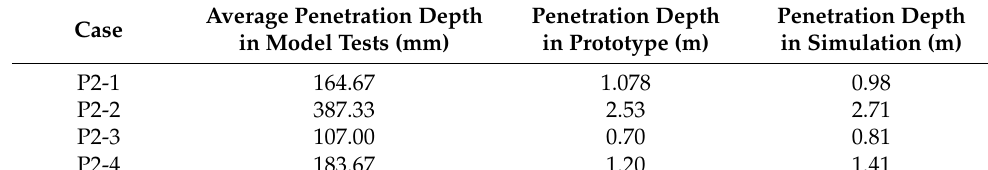
Table 15. Comparison of the penetration depth in the model test and numerical simulation.